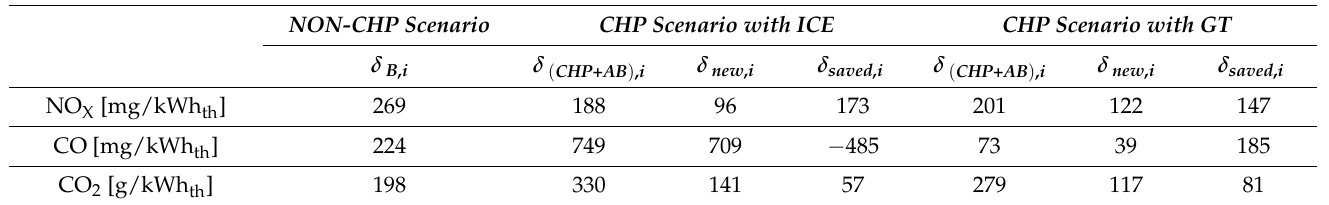
Table 11. Environmental results, expressed as specific emissions, for the case study